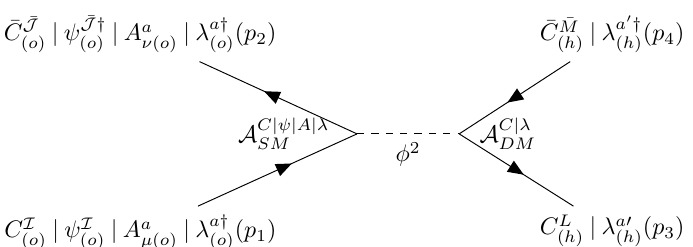
Figure 1. Possible chiral dark matter production mechanisms via the φ 2 modulus portal. The massive φ 2 modulus can be produced by scalar-scalar, fermion-fermion, boson-boson and gaugino- gaugino scattering in the thermal bath of particles in the observable sector created during reheating. Based on the expected mass spectrum and the possible interactions between the observable sector thermal bath and the hidden sector fields, we identified the hidden matter scalars C L 1 , . . . , N , and hidden gauginos λ a 0 , as the possible dark matter candidates within our theoretical ( h ) ( h ) context. For the observable sector gauginos, the index a runs over the adjoint representation of SU(3) SU(2) U(1) and any further extension of the standard model gauge group–such as C × L × Y U(1) in the B − L MSSM. For the hidden sector gauginos, the index a 0 runs over the adjoint B − L representation of the hidden sector group H which does not contribute to gaugino 1